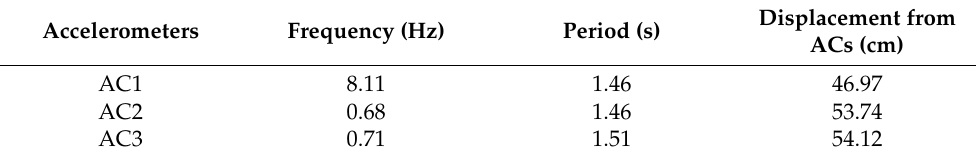
Table 12. Dynamic properties of the IBS frame for test